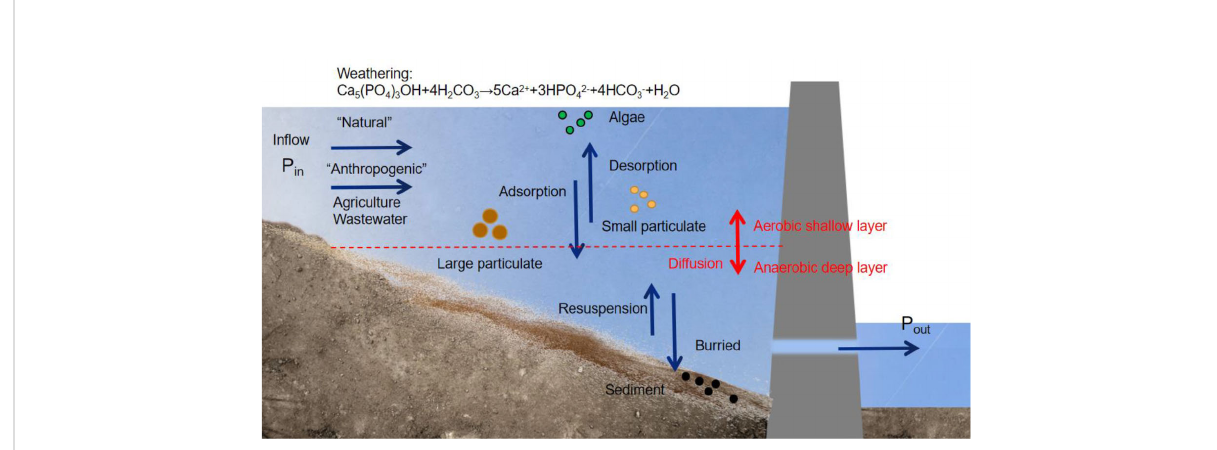
FIGURE 2 Migration and transformation processes of phosphorus in a